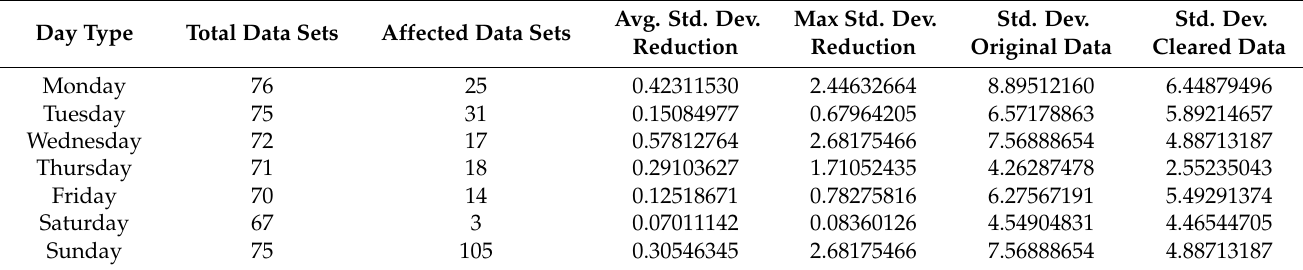
Table 13. Semester I baseline for original and cleared data sets.